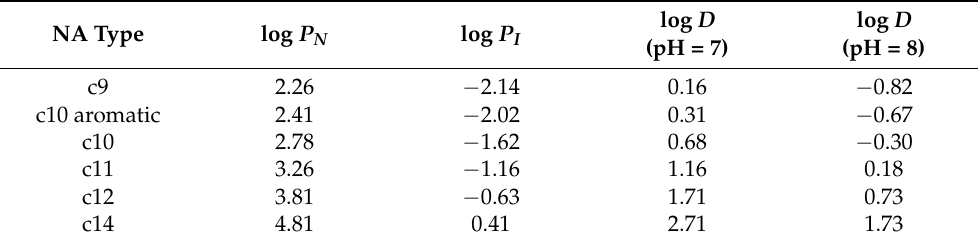
Table 1. Octanol–water partition coefficients (log P ) for neutral (N) and ionic (I) species, and distribu- tion coefficients (log D ) of the naphthenic acids calculated using the IEFPCM-MST B3LYP/6-31G(d) continuum solvent